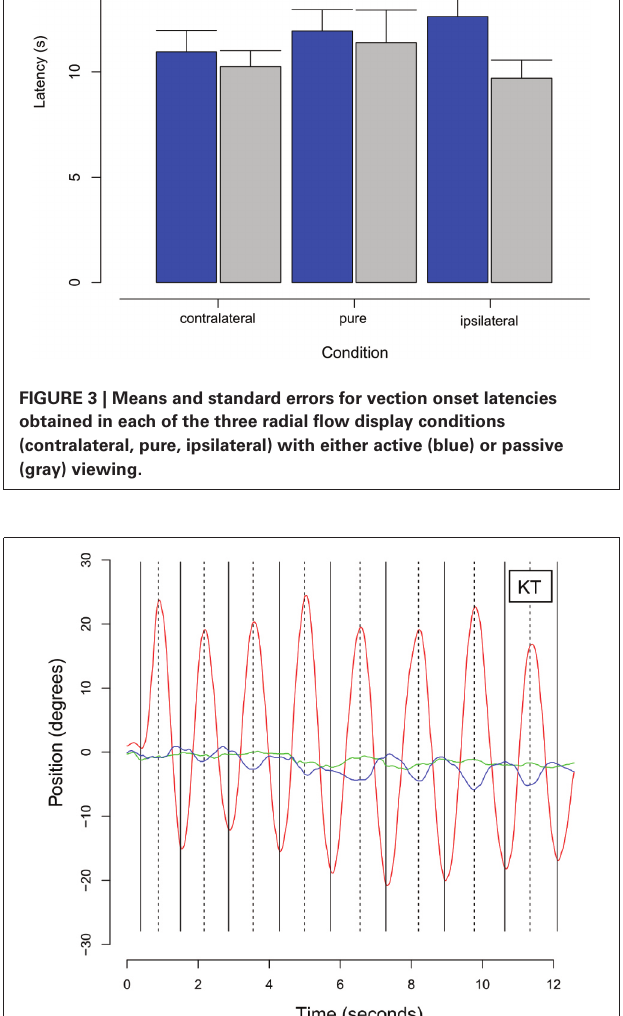
derivative of angular head orientation (vertical solid and dashed lines). Overall amplitude of excursion of the head in the yaw plane was computed for each observer in each active condition as the mean peak-to-peak amplitude of head rotation. The mean amplitude range of yaw head rotation was 43.6° (SD = 18.0°). A repeated-measures ANOVA found no significant difference in the amplitude of yaw head rotation across the three active experimental conditions ( F 2,12 = 1.21, p =